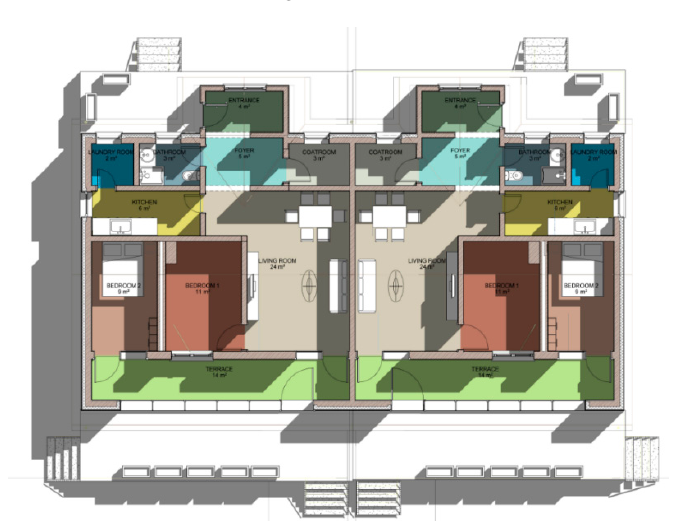
Figure 6. Organization of functions.